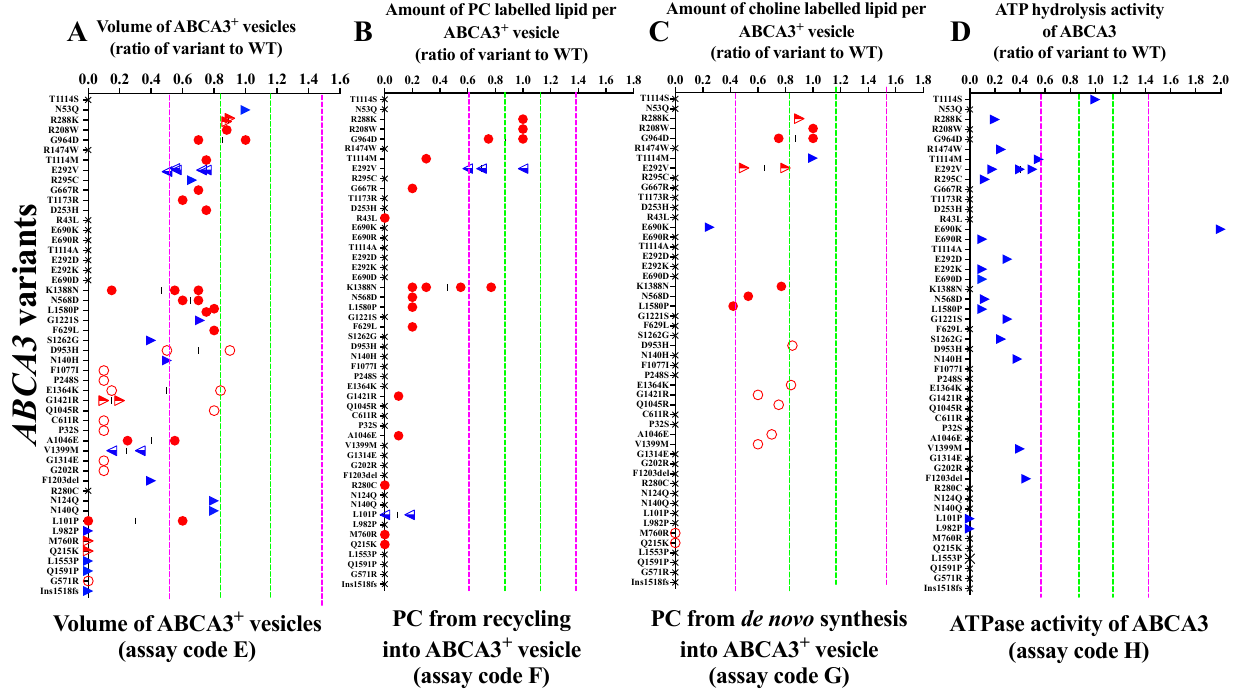
Figure 4. Data on the pumping of the ABCA3 variants: ( A ) volume of ABCA3 + vesicles; ( B ) PC from recycling into ABCA3 + vesicles; ( C ) PC from de novo synthesis into ABCA3 + vesicles; ( D ) ATPase activity of ABCA3. The green, dotted lines stand for ±1 nSD (fraction of WT nt). The purple, dotted lines stand for ±3 nSD (fraction of WT nt). The red, hollow circles represent data from this study. The red, solid circles represent data from our previous experiments. The red, semi-hollow triangles represent data from this study and the literature. The blue, semi-hollow triangles represent data from our previous experiments and the literature. The blue, solid triangles represent data from the literature. The black crosses represent that assays were not performed. The dark-grey shadow represents defective trafficking. The light-grey shadow represents impaired trafficking. No shadow: normal trafficking. The assay code refers to Figure 1.